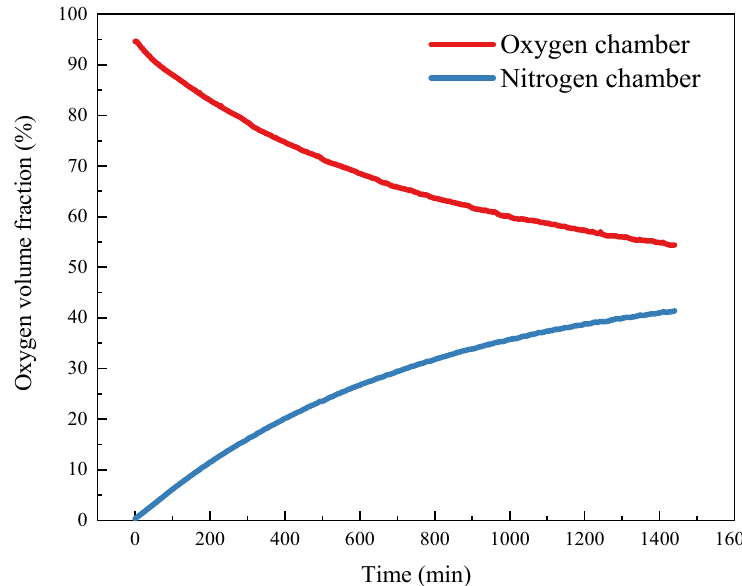
Figure 5. Oxygen volume fraction change in terms of diffusion time in two gas chambers.